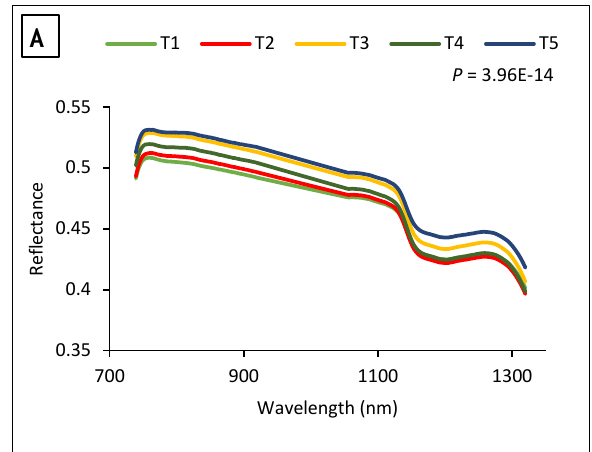
Figure 4. Region A Discriminating Treatment Levels